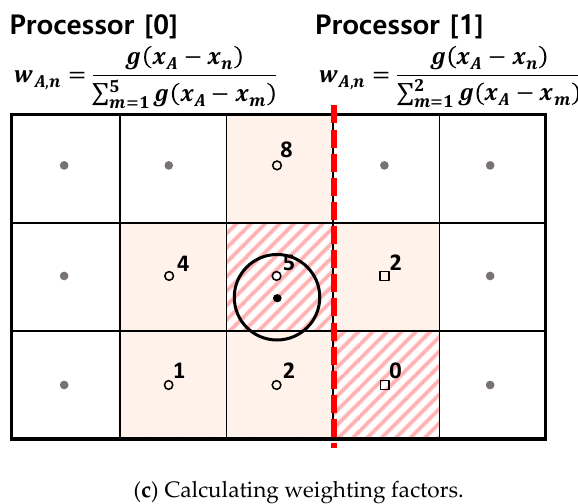
Figure 2. Data transfer between two processors. ( a ) Detecting the cells; ( b ) Listing sub-cells; ( c ) Calculation of the weighting factors.